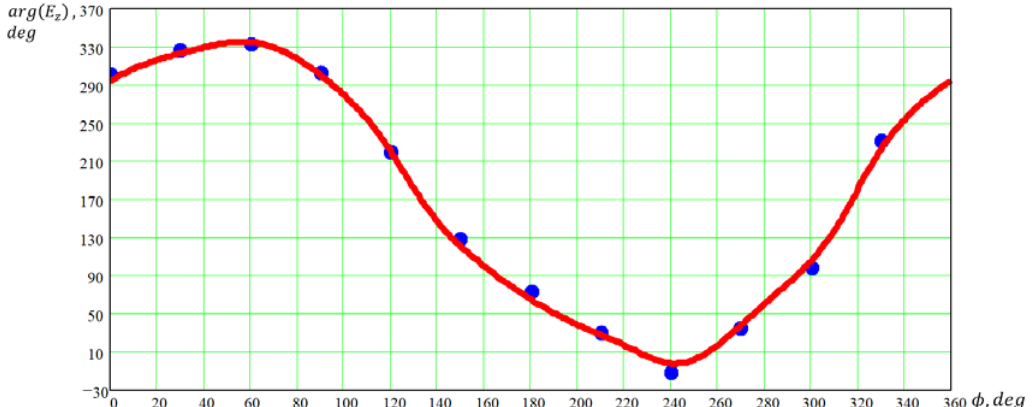
Figure 4. Phase distributions of 𝐸 (cid:3053) ‐ field on a circle with radius 𝑟 (cid:3404) 1 m (antenna array radius 𝑅 (cid:3404) 0.5 m) obtained by numerical simulation (circles) and approximation (solid lines) at frequency 𝑓 (cid:3404) 90 MHz.